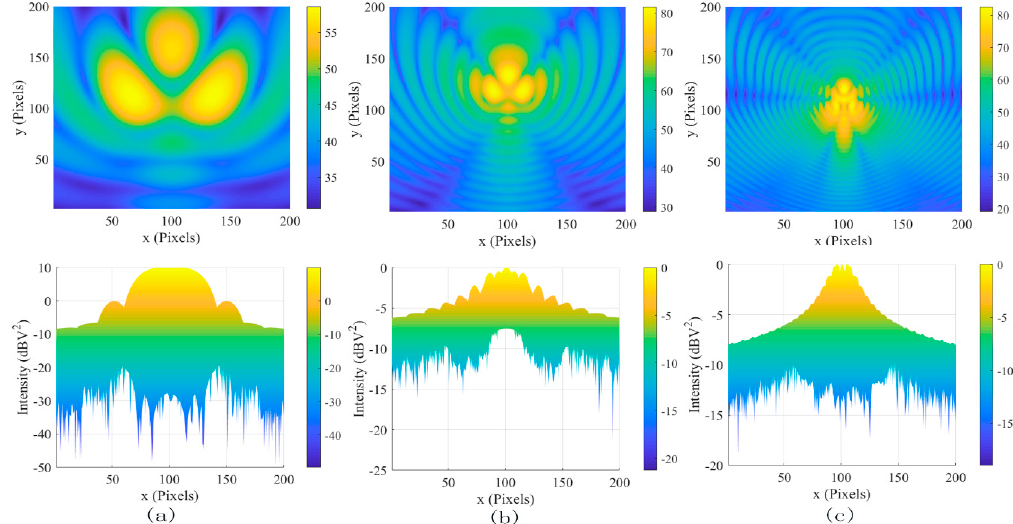
Figure 1. The images of coherent interference sources and the distribution of the logarithm of the coherent noise intensity in the images. ( a ) At 2 GHz, ( b ) At 4 GHz, and ( c ) at 6 GHz.